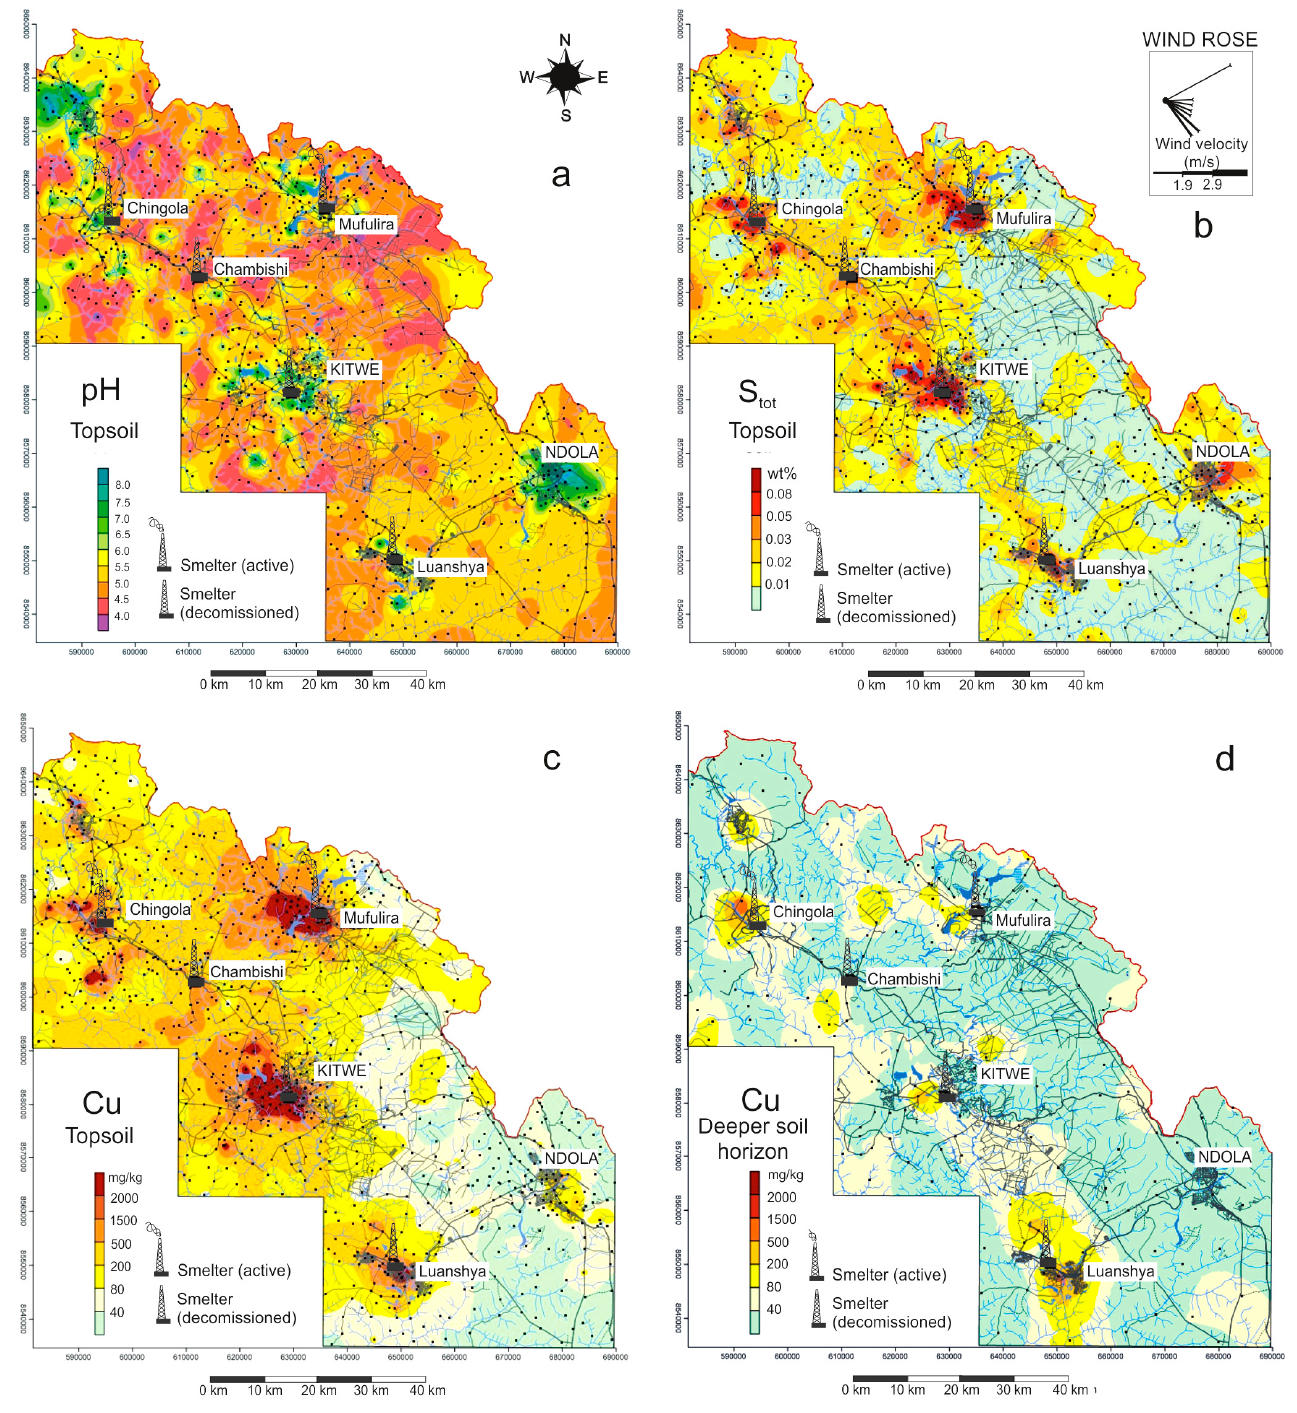
Figure 7. Contour maps of selected parameters on Zambian Copperbelt Mining districts. ( a ) Contour map of the pH values in the topsoil, ( b ) contour map of the total S (Stot) in the topsoil, ( c ) contour map of the Cu concentrations in the topsoil, ( d ) contour map of the Cu concentrations in the deeper soil horizon. Sampling sites are shown as black dots. Modified after K ř íbek and Nyambe [74].